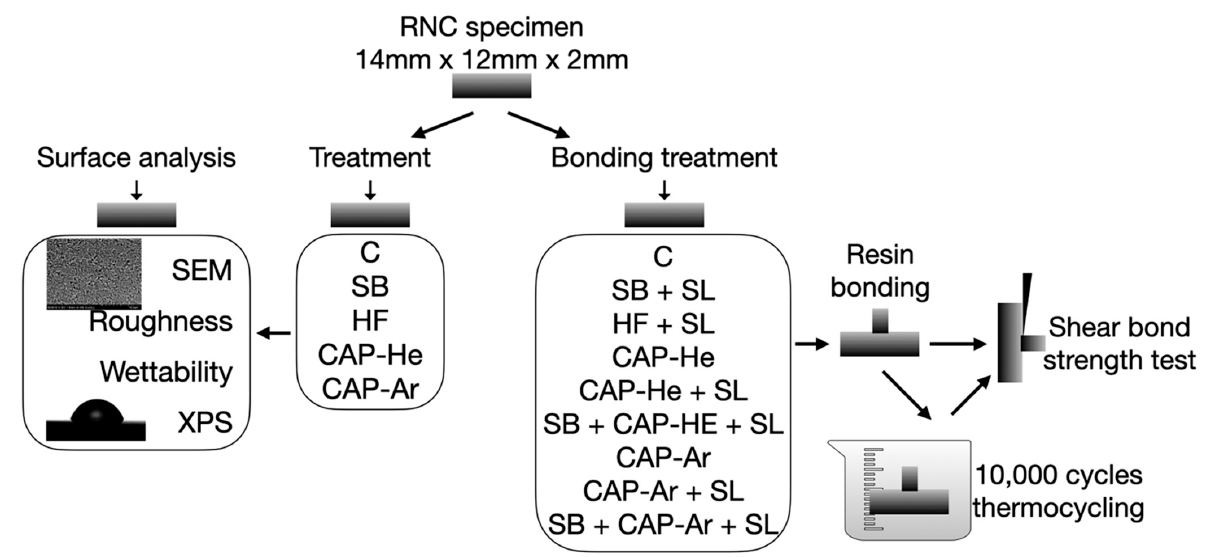
Figure 1. The schematic design of the study.